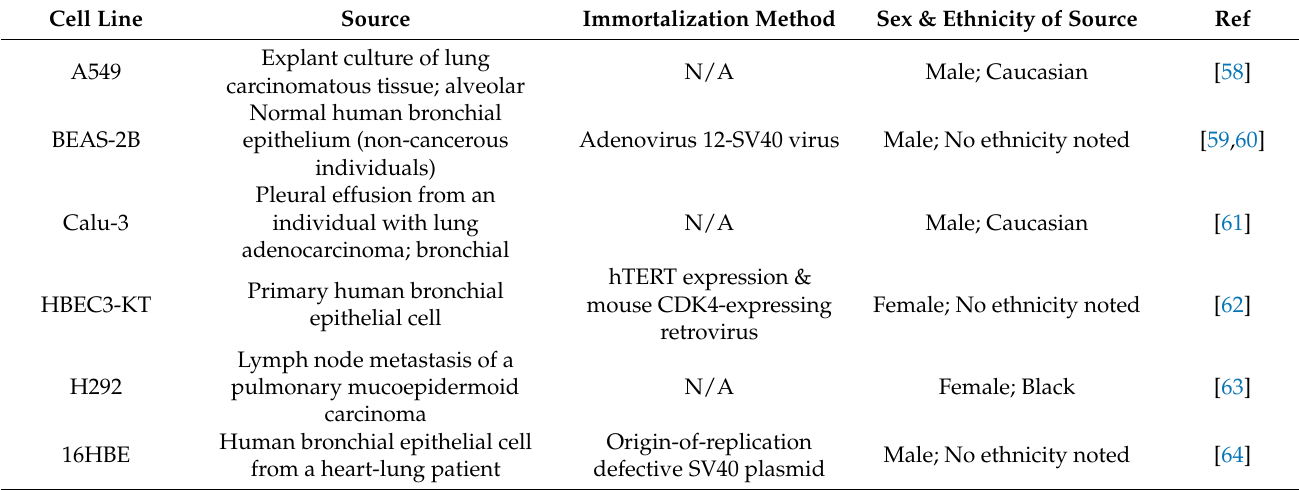
Table 2. Human respiratory epithelial cell